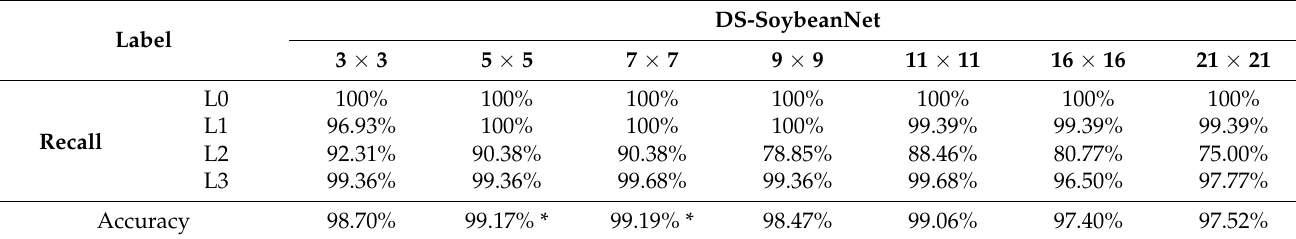
Table 7. Classification results of the proposed DS-SoybeanNet.